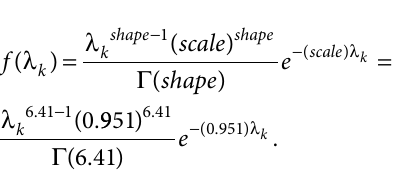
Table 2. The quantities of the correlation coefficient in the model Model R R square 1